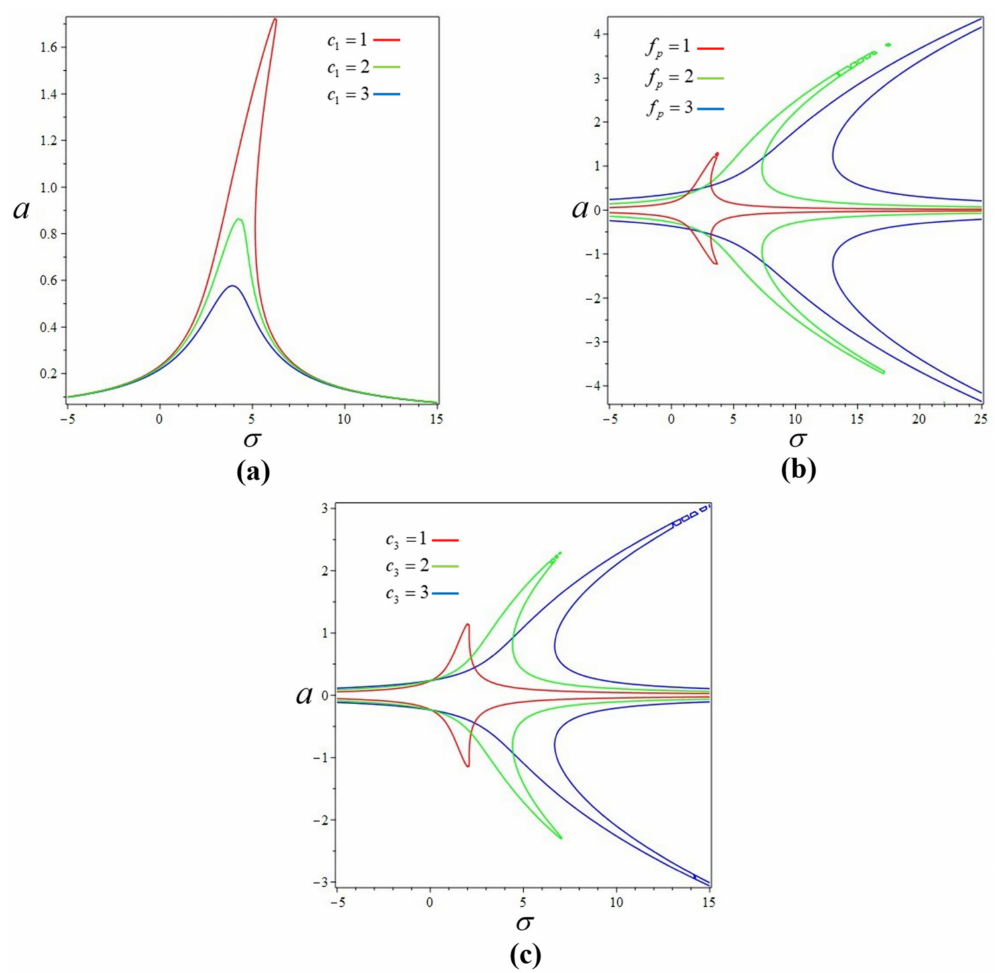
Figure 10. Frequency response for superharmonic resonance: ( a ) different damping values, ( b ) differ- ent external excitations, ( c ) different cubic nonlinear